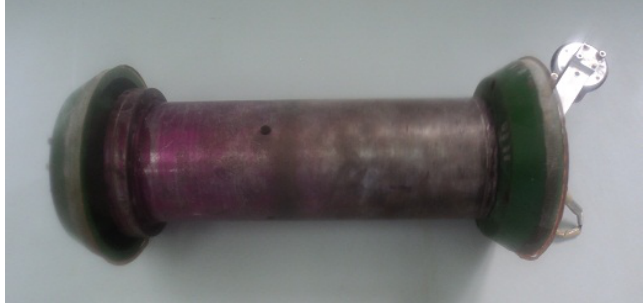
Figure 5. Prototype PIG. Source: By authors.